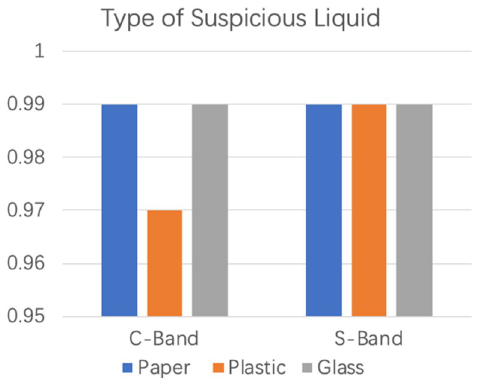
Figure 9. The KNN algorithm Classification results of Step 2 at the C-band and the S-band.